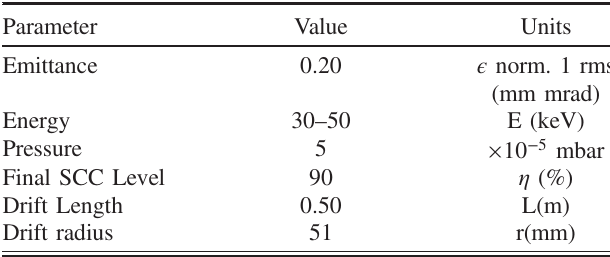
TABLE I. Drift simulation input